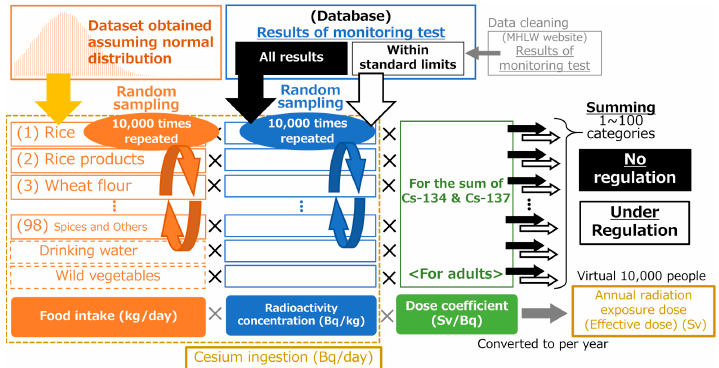
Figure 1. Summary of the dose estimation procedure. First, repeated random sampling of food intake was conducted for every food classification. Next, random sampling for the monitoring inspec- tion results was repeated within limits or for all results. The internal exposure dose of 10,000 persons was calculated as the product of the food intake, the radioactivity concentration of monitoring test results, and the dose coefficient. The number in parentheses in front of the food category name rep- resents a small classification number in the National Health and Nutrition Survey (NHNS), Japan.